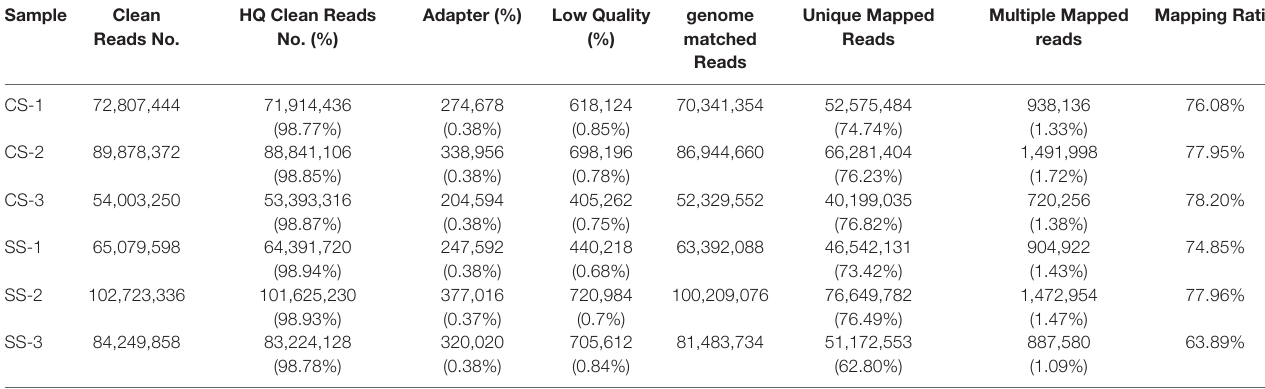
TABLE 1 | Statistics of reads for the transcriptome sequencing. Sample Clean Reads